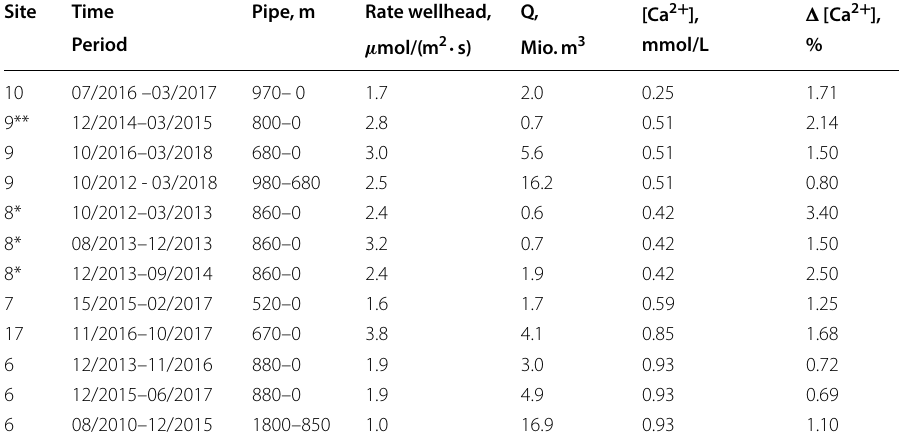
Calculations marked with * and ** are based on gauge measurements of Herbrich (2016), respectively Wanner et al. (2017)